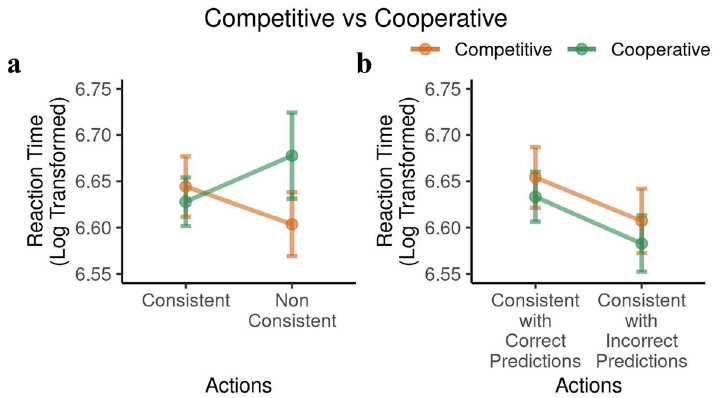
Figure 12. Comparison of reaction times (RTs) based on logical consistency of actions. Using 2-way mixed effects ANOVA we observed no interaction effect of the context and the consistency of actions in ( a ). Using